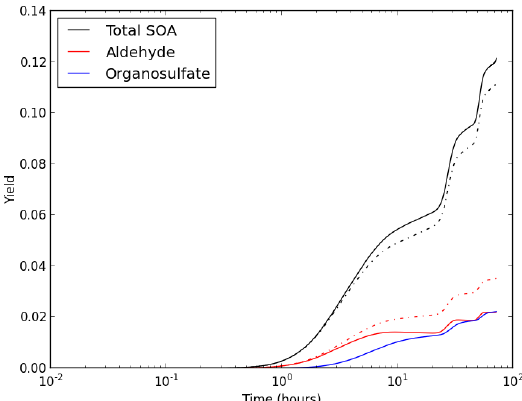
Figure 9. Yield of formation of SOA, aldehydes and organosulfates with (solid lines) or without (dashed lines) the conversion of alde- hydes into organosulfates as a function of time for an organic mass loading of 5µgm − 3 with 2µgm − 3 of